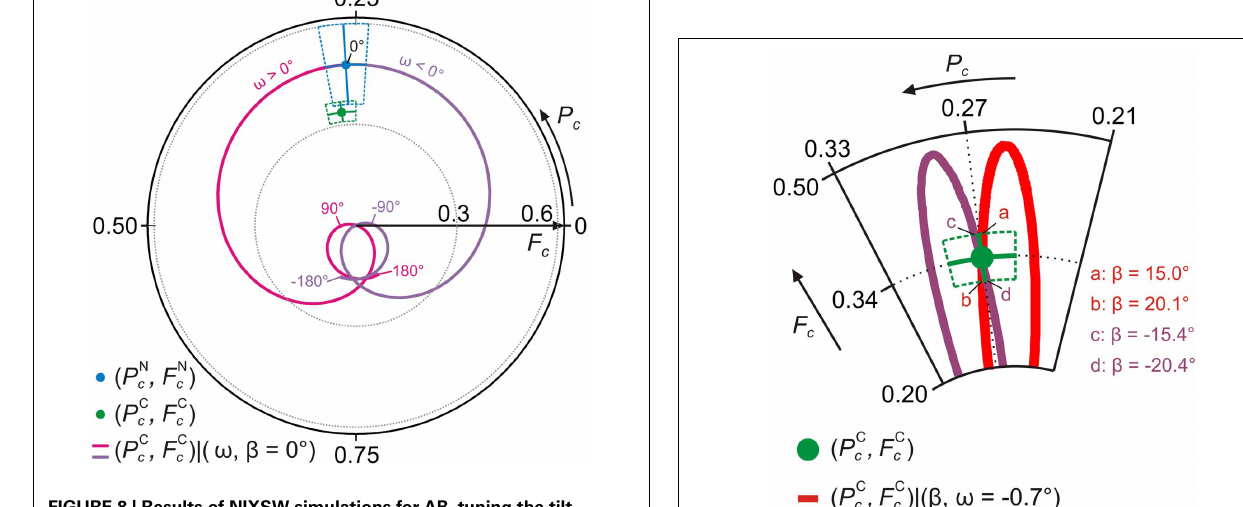
FIGURE 8 | Results of NIXSW simulations for AB, tuning the tilt angle ω . Argand diagram of the NIXSW experimental results (green and blue dots, Figure 6 ) and NIXSW simulations of carbon structure parameters ( P C c , F C c ) for − 180 ◦ ≤ ω ≤ 0 ◦ (violet line) and 0 ◦ ≤ ω ≤ 180 ◦ (magenta line) with β = 0 ◦ and d N − Ag = 2 . 97Å.